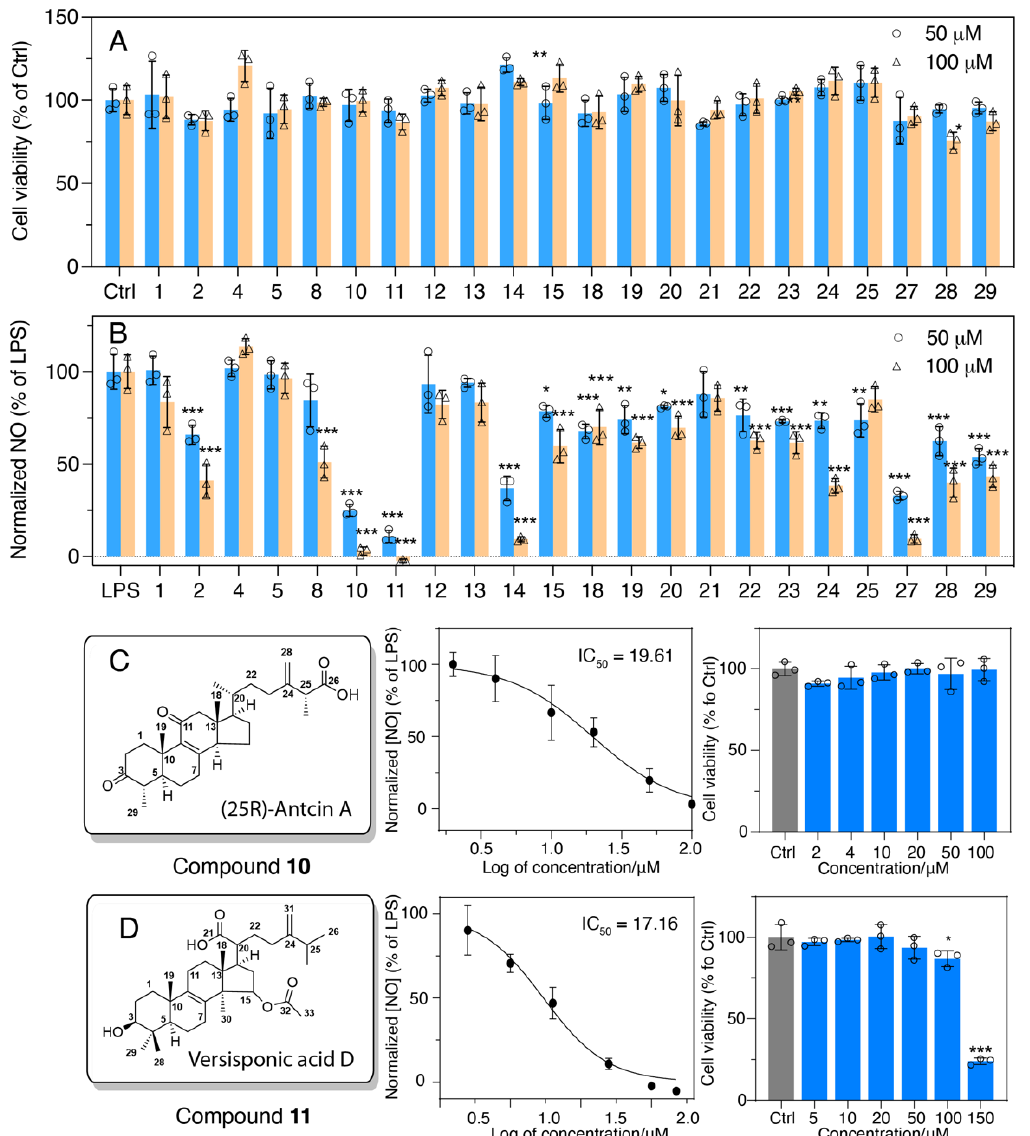
Figure 5. Anti-inflammatory activities of bioactive compounds isolated from Antrodia cinnamomea . ( A ) Cell viability of cells treated only with compounds 1 – 29 . Dose – response curve of normalized NO with the treatment of 100 ng/mL LPS with 10 . ( B ) Nitric oxide production of RAW 264.7 cells treated with 100 ng/mL LPS and compounds 1 – 29 isolated from Antrodia cinnamomea . ( C ) Compound 10 and ( D ) 11 and their cytotoxicity. Results are shown as mean ± S.D, n = 3, p * < 0.05, p ** < 0.01, p *** < 0.001 vs. LPS or control.